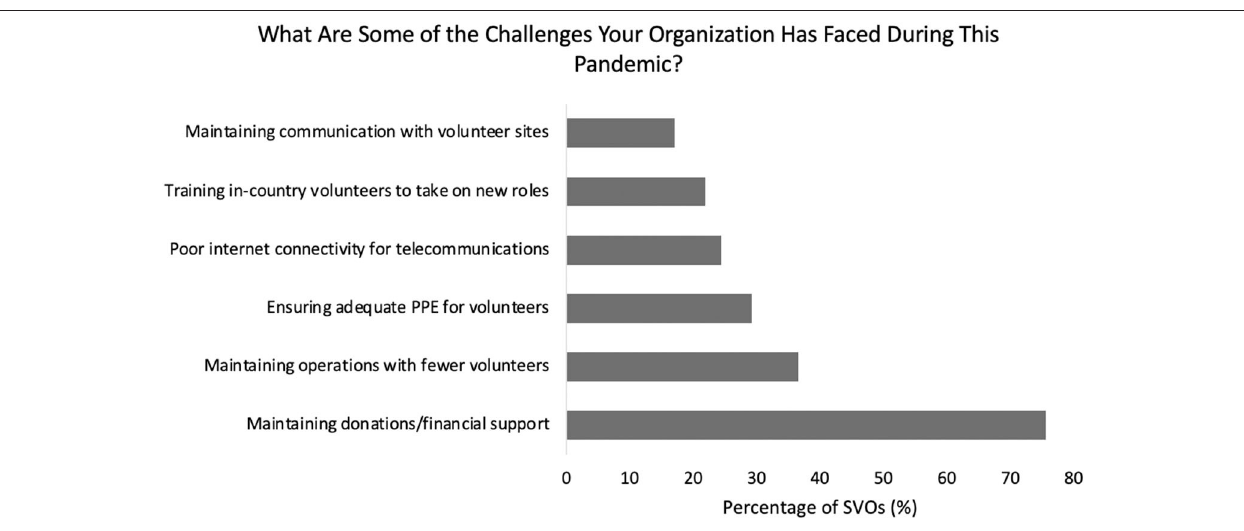
FIGURE 3 | Breakdown of challenges faced by surgical volunteer organizations during the